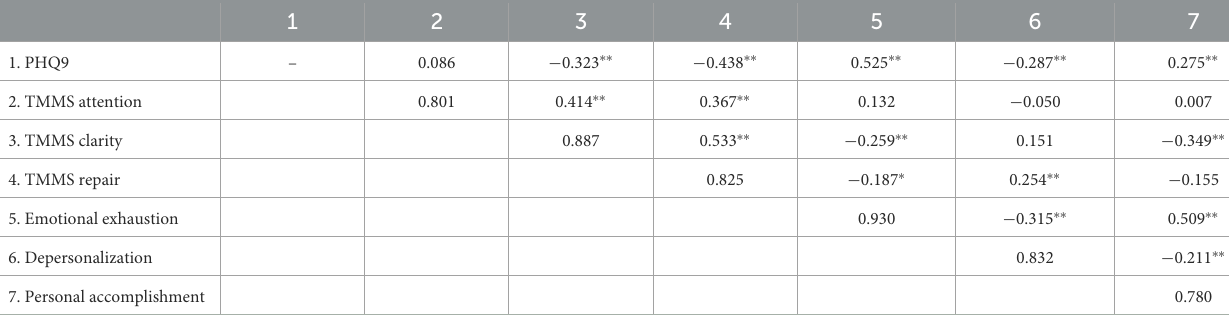
TABLE 2 Relationships between PHQ9, burnout, and emotional intelligence.